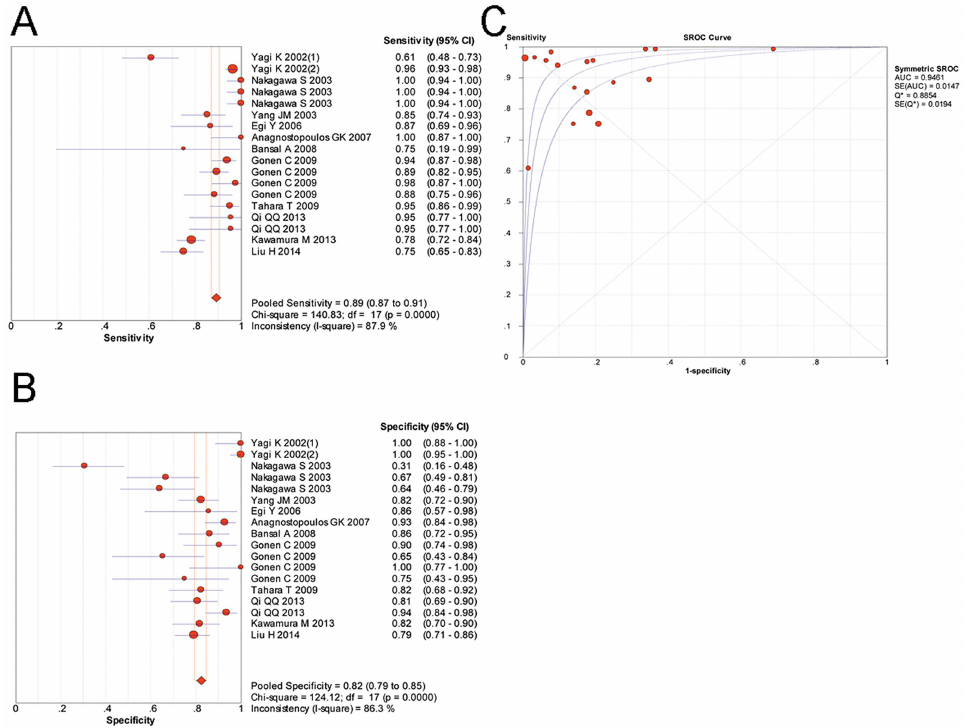
Fig 4. The diagnostic performance of magnifying endoscopy in predicting H . pylori infection. (A), pooled sensitivity; (B), pooledspecificity; (C), summary receiver operatingcharacteristic curve for diagnosis by magnifyingendoscopy. CI, confidenceinterval; AUC, area under the curve; SE,